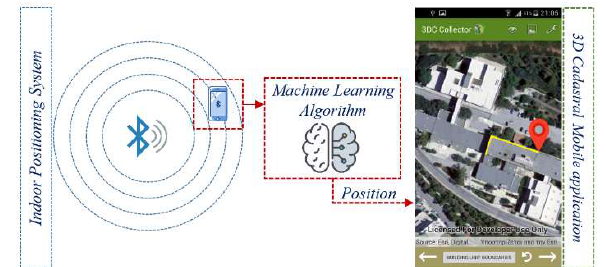
Figure 3. 3D cadastral indoor mapping – Framework overview